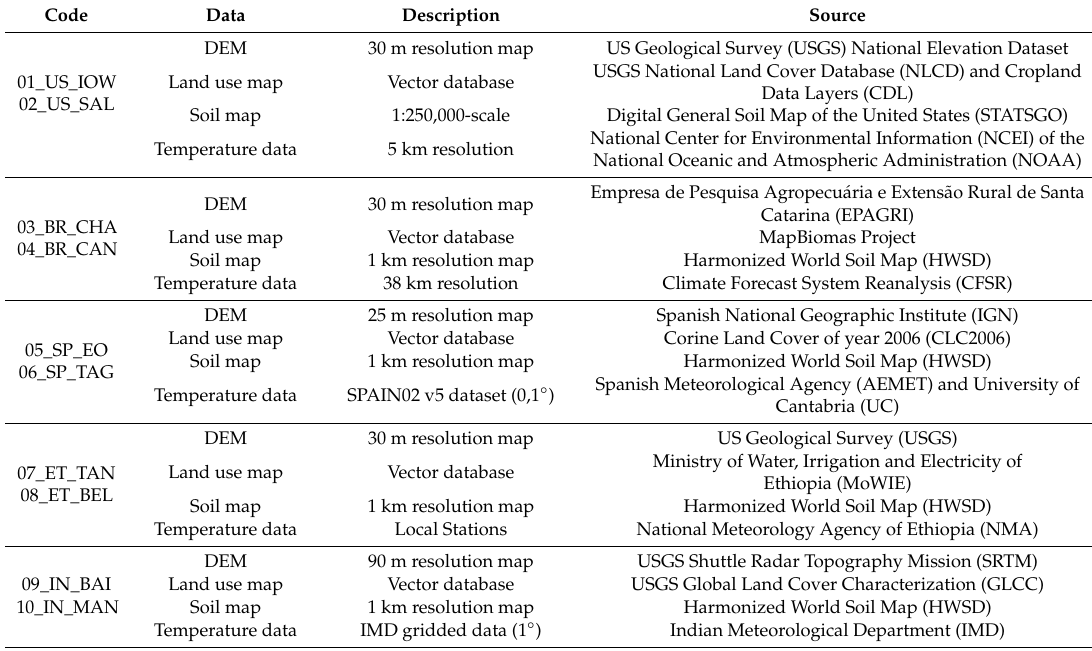
Table 3. Description of the nature and source of datasets employed in the